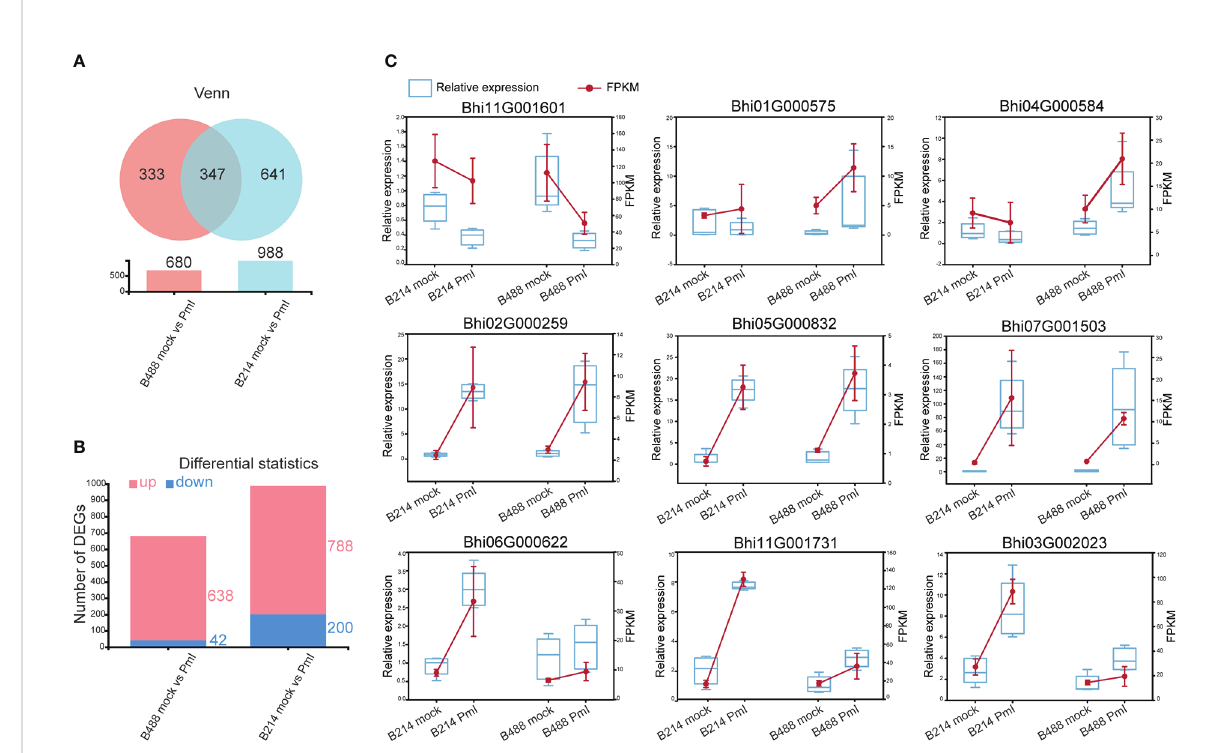
FIGURE 2 DEGs and the validation of selected DEGs using qRT-PCR. (A) Venn diagrammatic analysis of DEGs in B488 and B214. (B) up- and downregulated DEGs in B488 (mock infection vs. PmI) and B214 (mock infection vs. PmI). (C) Randomly selected DEGs expression tendency of qRT-PCR data compared with RNA-seq FKPM